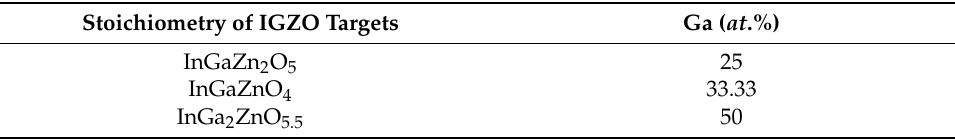
Table 1. Stoichiometry and Ga contents of IGZO